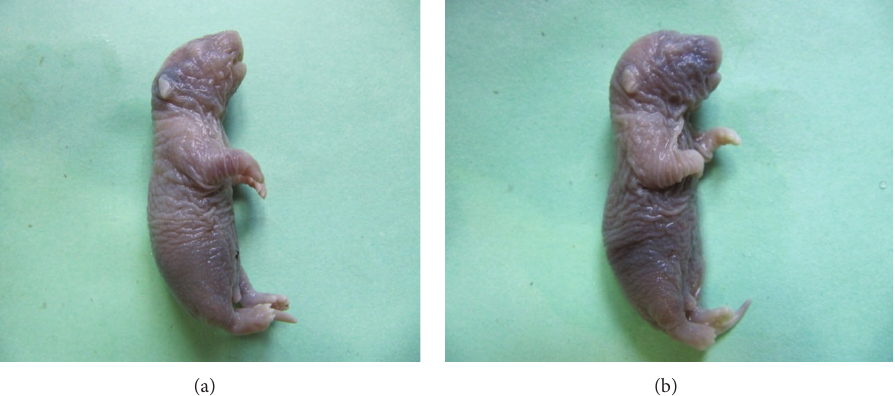
Figure 1: Macroscopic view of 17-day-fetuses from control group (a) and the group that received a combination of clomipramine and caffeine in high doses (b). In the control group fetus, the muzzle is formed normally. The body is C-shaped and eyes, ears, and upper and lower extremities are in their normal locations. The skin is taut (a). In the fetus from the group treated with clomipramine and caffeine in high doses, the body is not fully C-shaped, the forelimbs are bent, and corrugated skin and areas of subcutaneous hemorrhage are obvious (b).